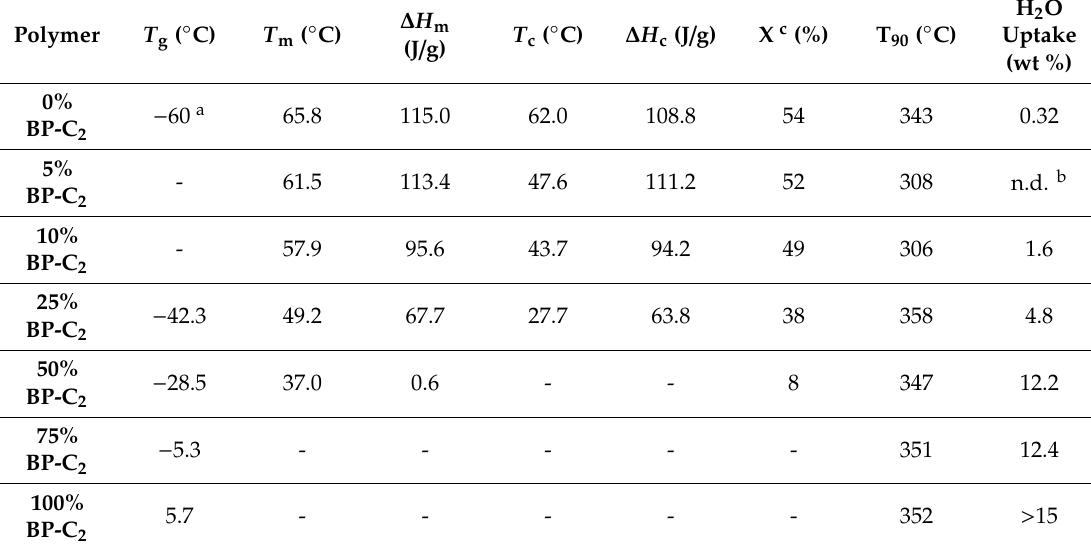
Table 2. Overview of the thermal transitions ( T g , T m , ∆ H m , T c , ∆ H c , obtained from di ff